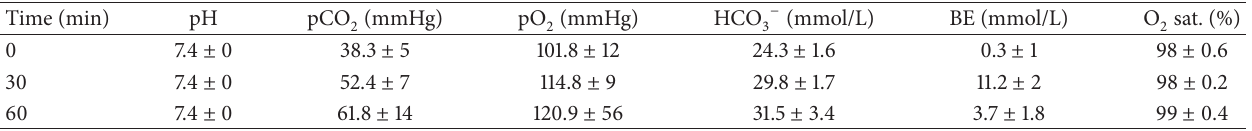
), oxygen partial 2 Sat) during spontaneous ventilation (SV) 2